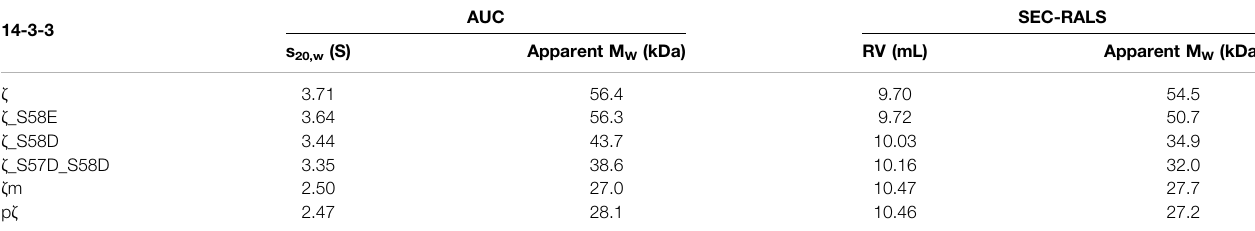
TABLE 1 | AUC and SEC-RALS parameters characterizing the oligomeric state of 14-3-3 ζ proteins. The oligomeric state of proteins (36.5 μ M) was analyzed at 20 ° C.